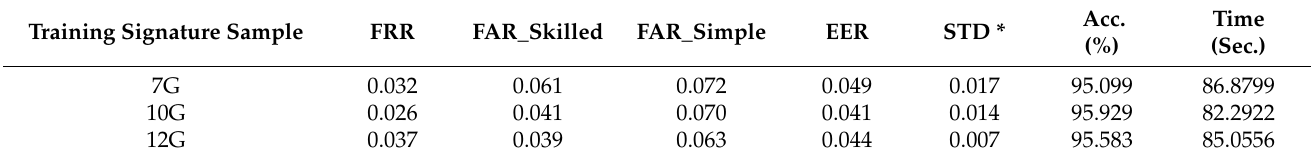
Table 7. Results of the proposed model on the SID database.